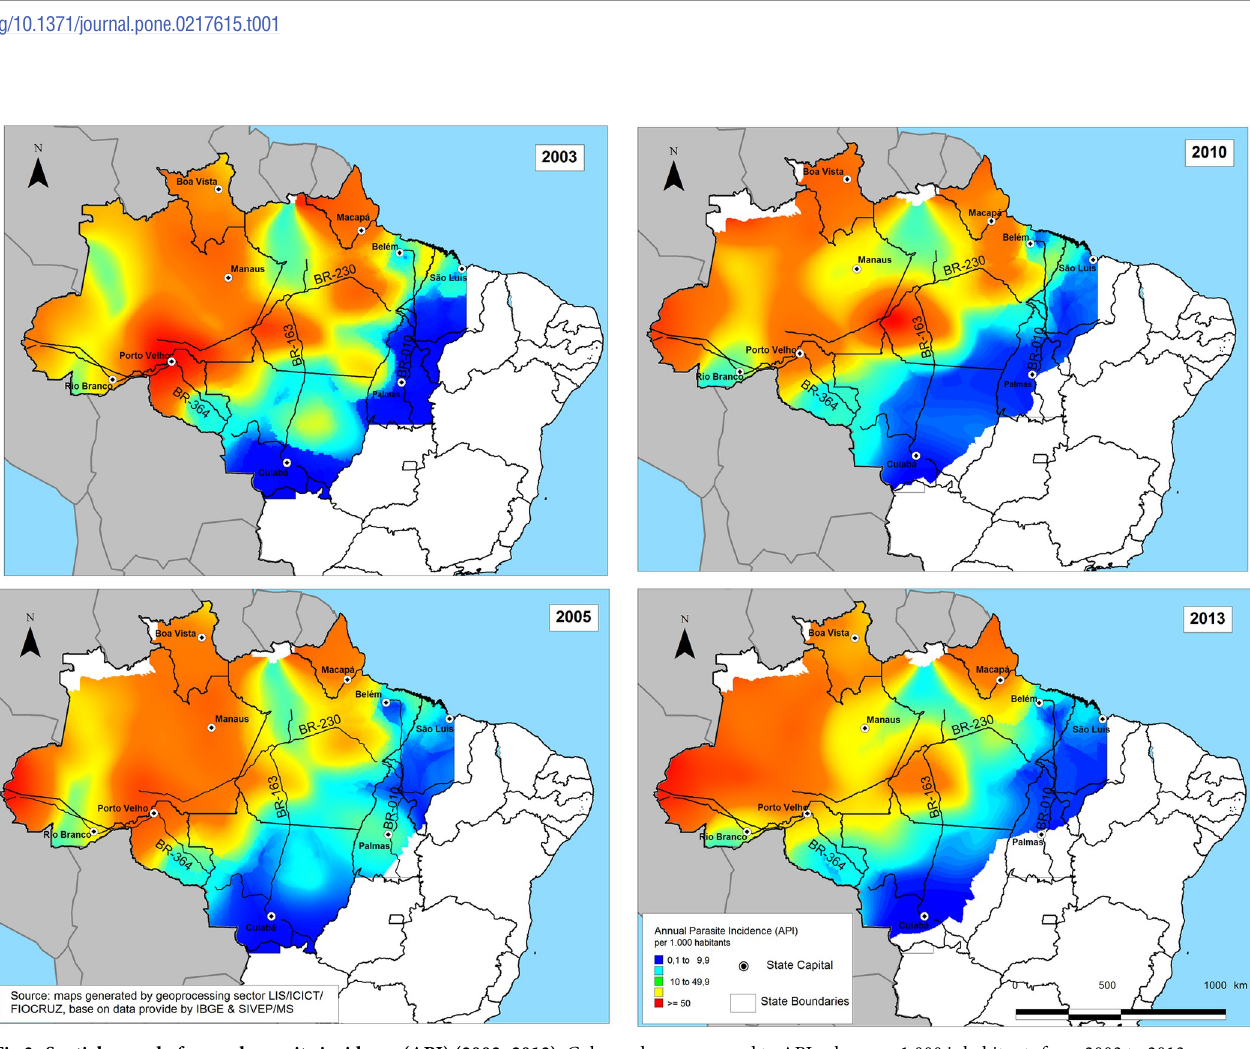
PLOS ONE | https://doi.org/10.1371/journal.pone.0217615 June 18,